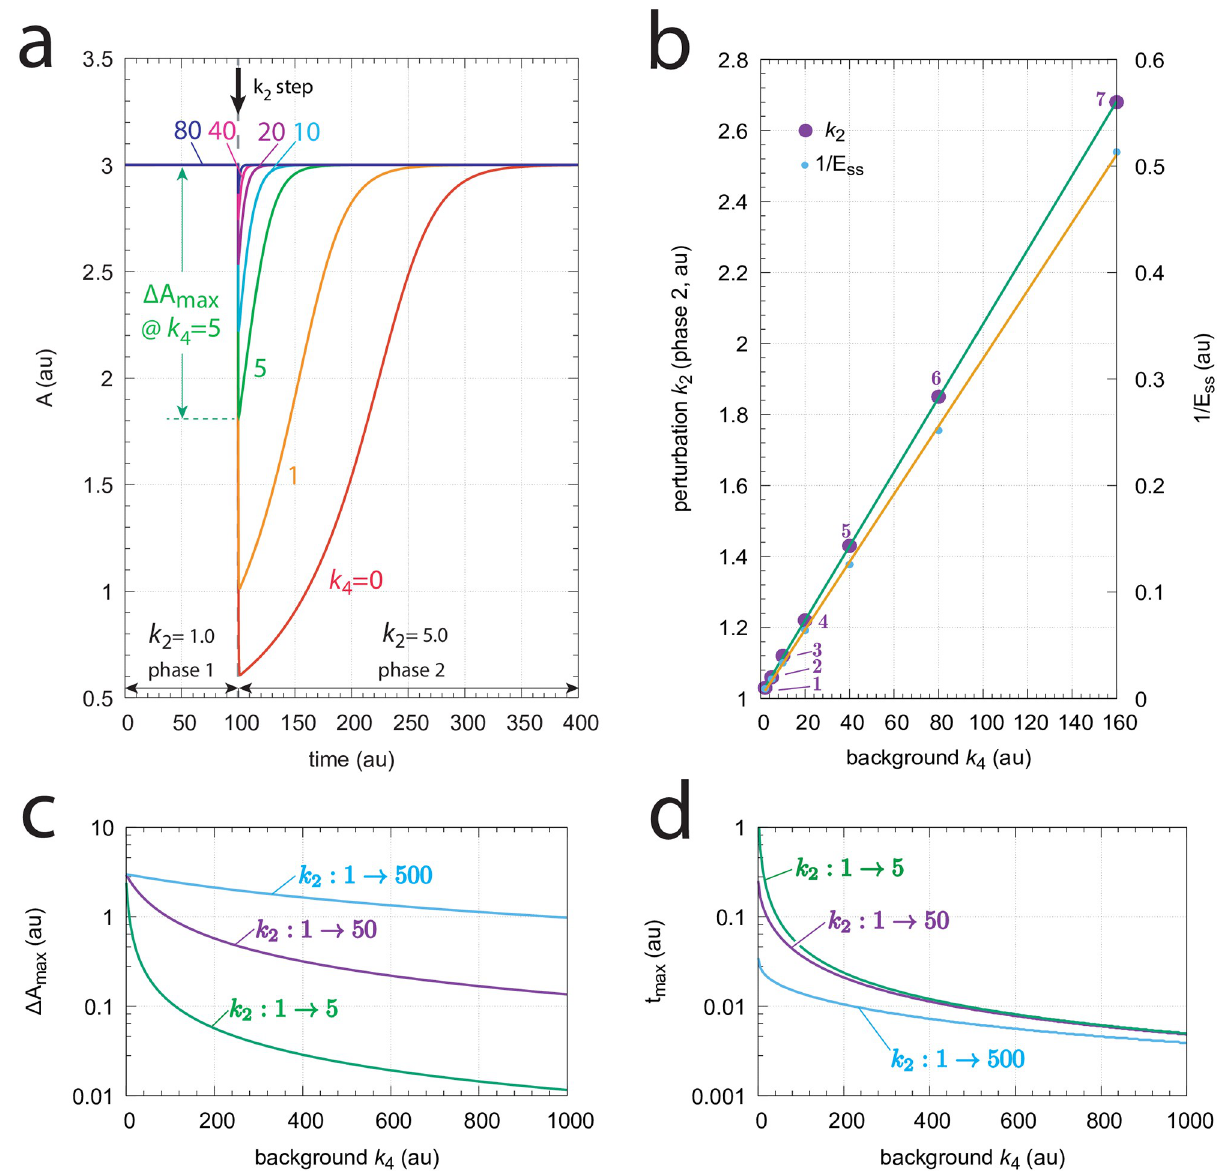
Fig 8. Response kinetics and relationship to Weber’s law in the m2 controller (Fig 7). The set-point of A is A =3.0 (a) Step-wise increase of k 2 from set 1.0 to 5.0 at time t =100 at different and constant background perturbations k 4 (0–80). The maximum excusion in A , Δ A max , for k 4 =5 is indicated. Note the successive decrease in Δ A max and the more rapid resetting of A at increased k 4 values. Rate constants (in au): k 1 =0.0, k 2 =1.0 (phase 1), k 2 =5.0 (phase 2), k 3 =1 × 10 4 , k 4 variable, k 5 =1.0, k 6 =3.0, k 7 =1 × 10 − 6 , k 8 =0.1. Initial concentrations (in au): A 0 =3.0, E 0 =333.23 ( k 4 =0); A 0 =3.0, E 0 =166.62 ( k 4 =1); A 0 =3.0, E 0 =55.46 ( k 4 =5); A 0 =3.0, E 0 =30.20 ( k 4 =10); A 0 =3.0, E 0 =15.77 ( k 4 =20); A 0 =3.0, E 0 =8.03 ( k 4 =40); A 0 =3.0, E 0 =4.02 ( k 4 =80). (b) Relationship to Weber’s ) are linear functions of the background perturbation k 4 when the “just noticable difference” Δ A is 0.03. law: in phase 2 the perturbation k 2 and (1/ E ss max Rate constants and initial concentrations as in (a), except that k 2 in phase 2 has the following values: 1 , k 2 = 1.0314 ( k 4 = 2); 2 , k 2 = 1.0627 ( k 4 = 5); 3 , k 2 = 1.1150 ( k 4 = 10); 4 , k 2 = 1.2195 ( k 4 = 20); 5 , k 2 = 1.4285 ( k 4 = 40); 6 , k 2 = 1.8465 ( k 4 = 80); 7 , k 2 = 2.6820 ( k 4 = 160). (c) Monotonic decrease of Δ A max as a function of background k 4 for three different steps. At constant background Δ A max increases with increasing step size. (d) t max decreases monotonically with increasing backgrounds k 4 . At constant background t max decreases with increasing step size. Rate constants in panels (c) and (d) are the same as for panel (a), apart from k 2 and k 4 . Initial concentrations were taken as the steady state values of A and E at the different backgrounds k 4 prior to the applied step in k 2 .